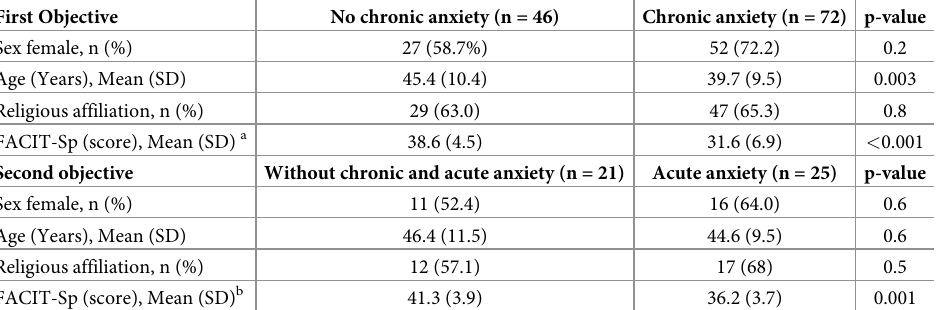
Table 1. Descriptive statistics of the variables used as predictors for the three groups: Anxiety that started pre- COVID-19 and during the pandemic (chronic anxiety), anxiety that started only during the pandemic (acute anxi- ety), and without chronic and acute anxiety